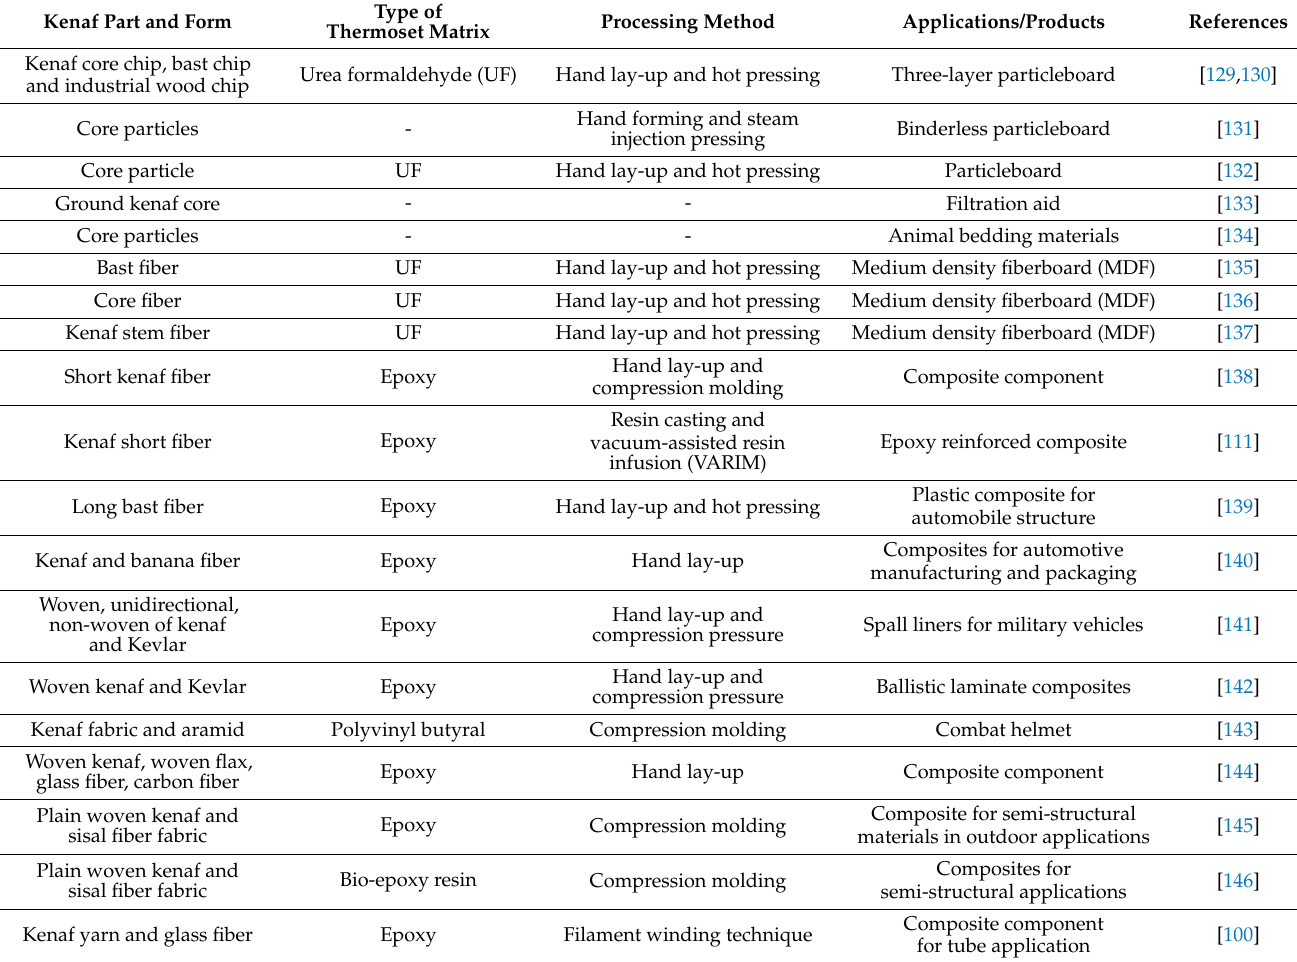
Table 3. List of reported studies on kenaf fiber reinforcement in various forms and its applications. Kenaf Part and